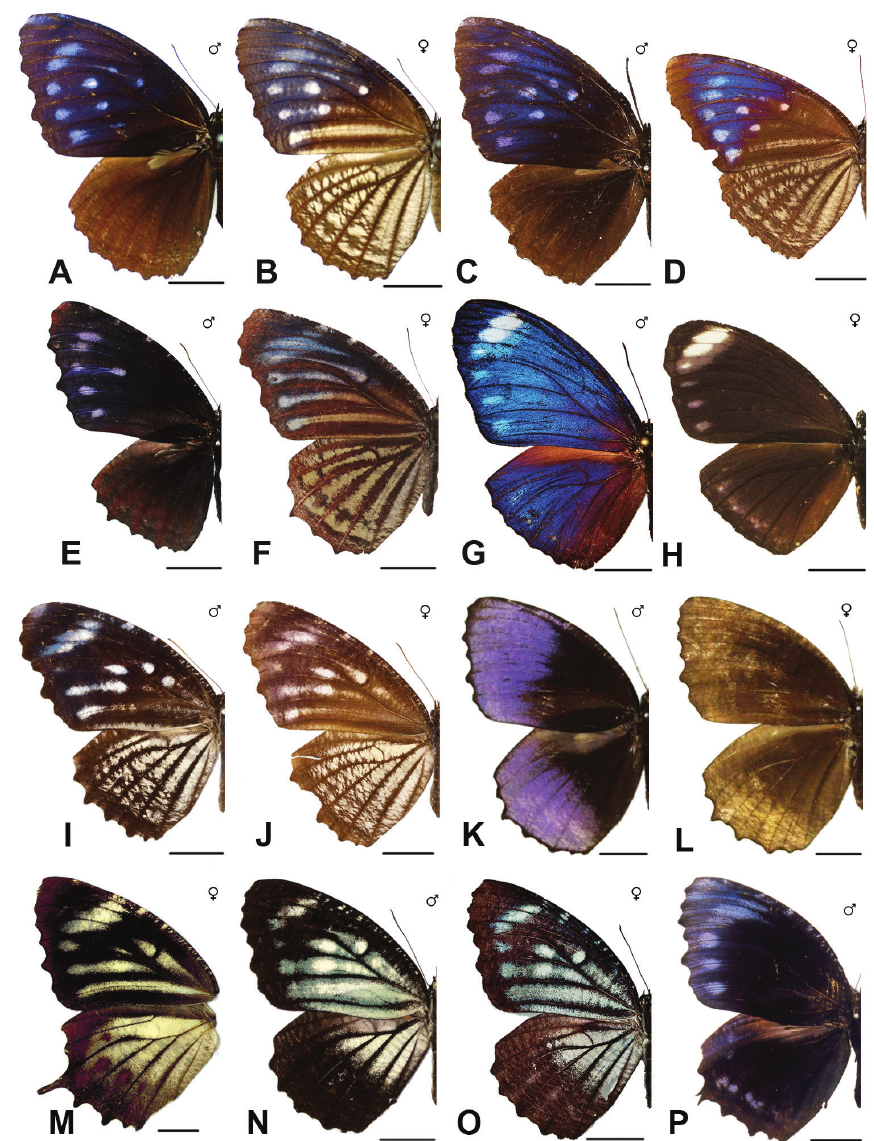
Figure 14. A malelas ♂ D NHM India: Sikkim B malelas ♀ D NHM India: Sikkim C malelas ♂ D MCZ Vietnam D malelas ♀ D KUTH Thailand: Chiang Mai E saueri ♂ D IPC Thailand: